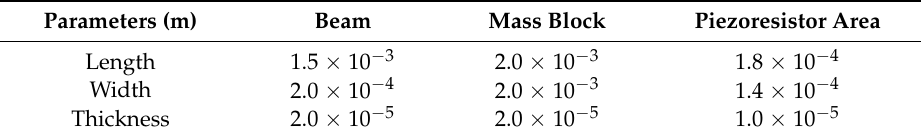
Table 1. Parameters of the MEMS electronic heart sound sensor